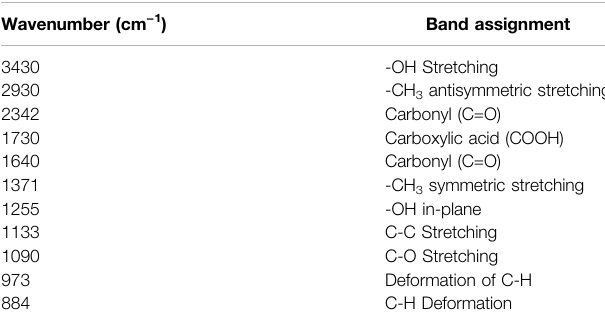
TABLE 2 | IR frequencies and assignments for functional groups in